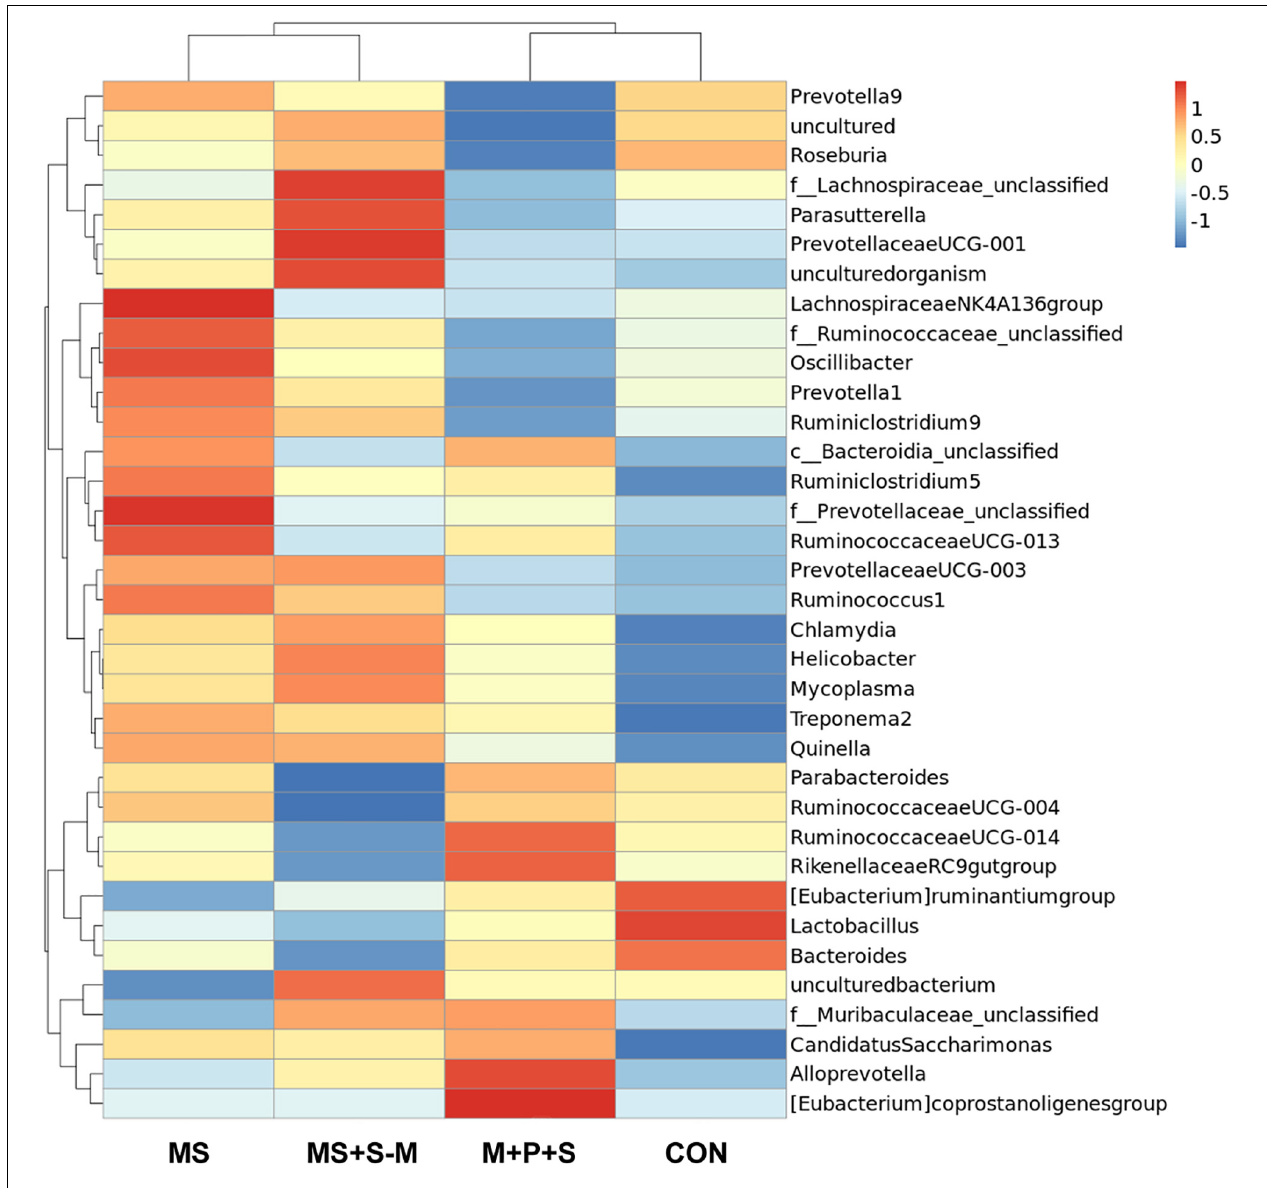
FIGURE 2 | Cluster heatmap analysis of the top 35 most abundant fecal microbiota at the genus level in experimental groups, control (Con), maternally separated pups (MS), mother with pups and stranger (M+P+S), maternally separated pups and stranger (MS+S–M).